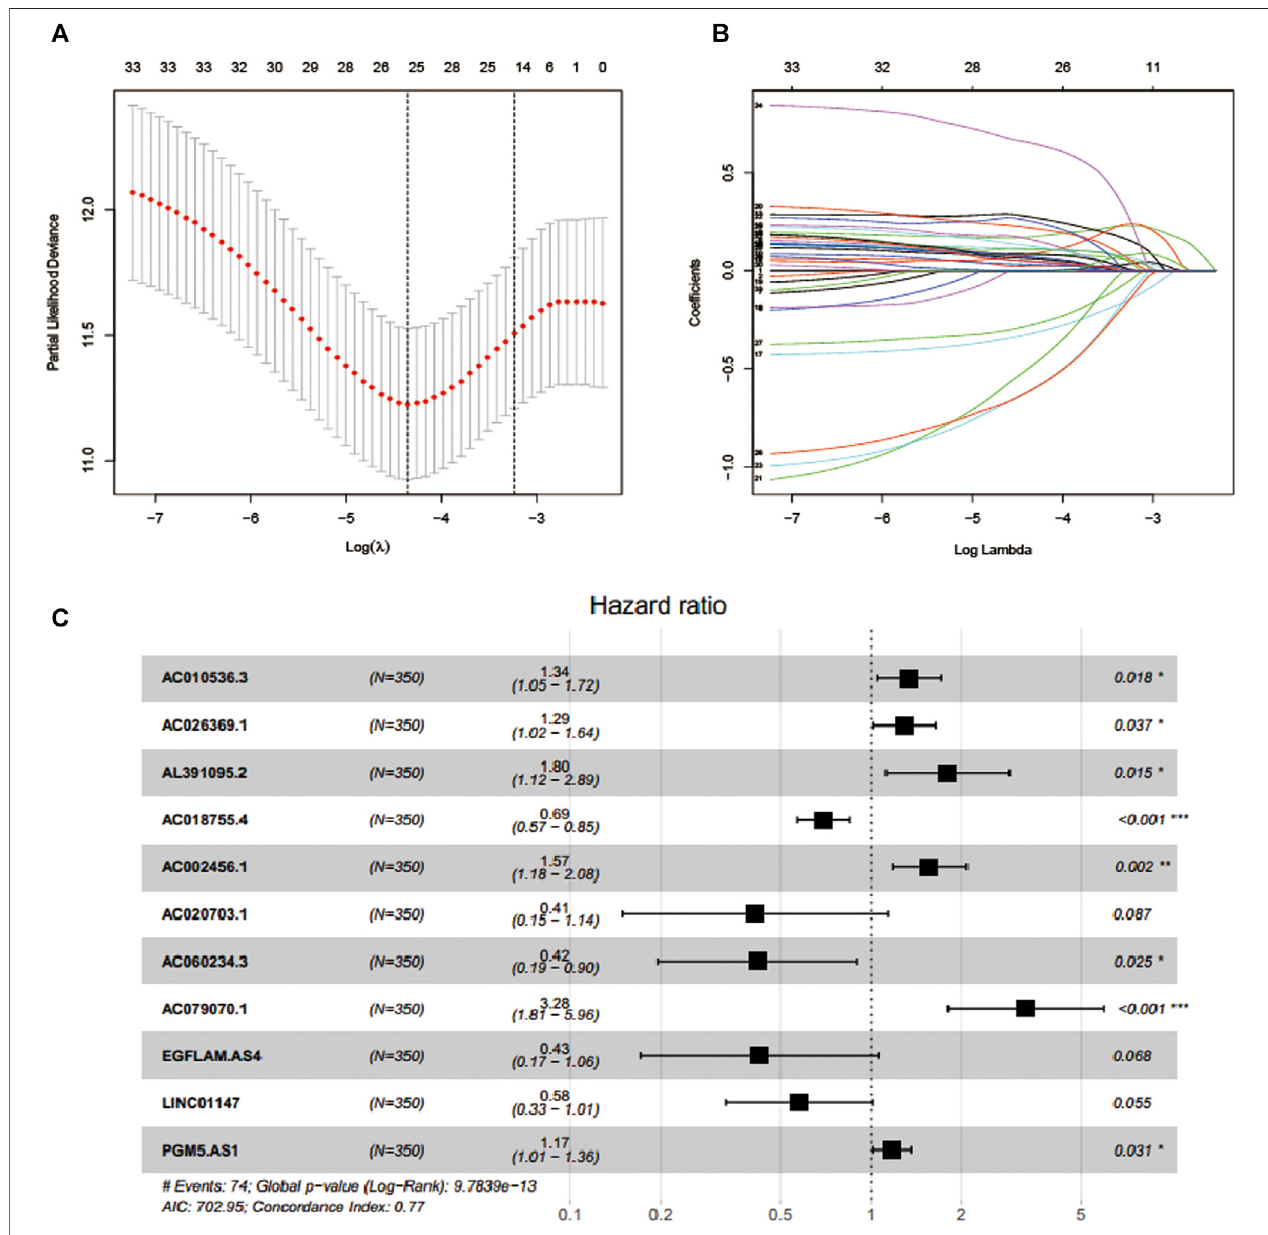
FIGURE1| FeatureselectionusingLASSOCOXregressionandmultivariateCoxregressionanalysis. (A) Selectionoftuningparameter( λ )intheLASSOregression using 10-fold cross-validation via minimum criteria. (B) LASSO coef fi cient pro fi les for clinical features and 25 nonzero coef fi cients are selected. C.11 lncRNAs were selected through multivariate Cox regression